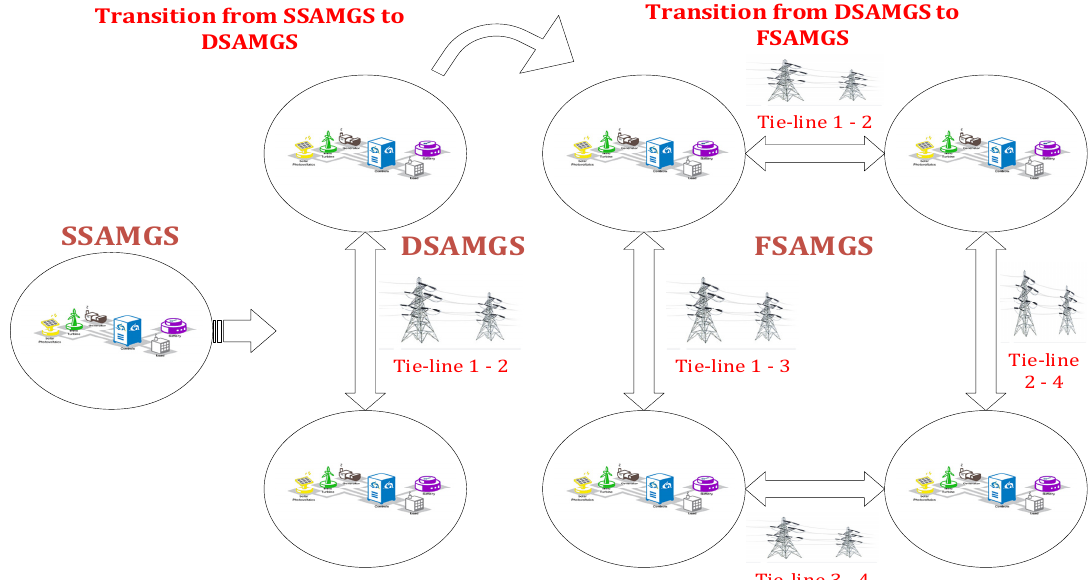
Figure 3. Transition from Single Area Microgrid to Dual and Four Areas Interconnected Stand-Alone Microgrid System, SSAMGS: Single Area Stand-Alone Microgrid System, DSAMGS: Dual Areas Stand-Alone Microgrid System, FSAMGS: Four Areas Stand-Alone Microgrid System. Table 6. Comparison of AGC schemes in microgrids networks. Ref.